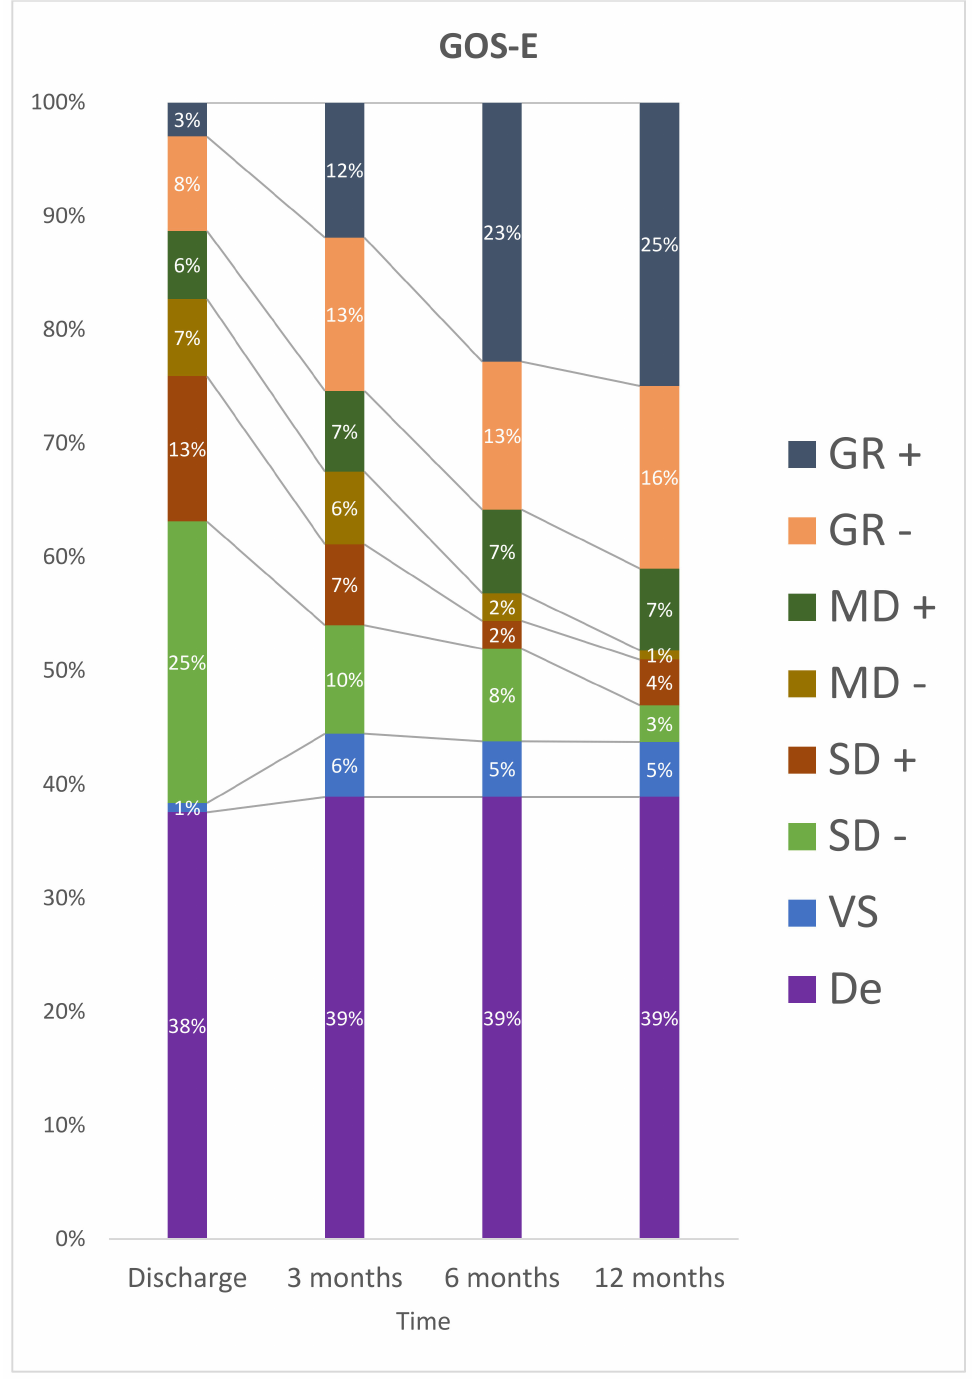
Figure 2. Stratification for GOS-E at discharge, 3 months, 6 months and 12 months after TBI. De: Death; GR– : Lower Good Recovery; GR+: Upper Good Recovery; MD–: Lower Moderate Disability; MD+: Upper Moderate Disability; SD–: Lower Severe Disability; SD+: Upper Severe Disability; VS: Vegetative